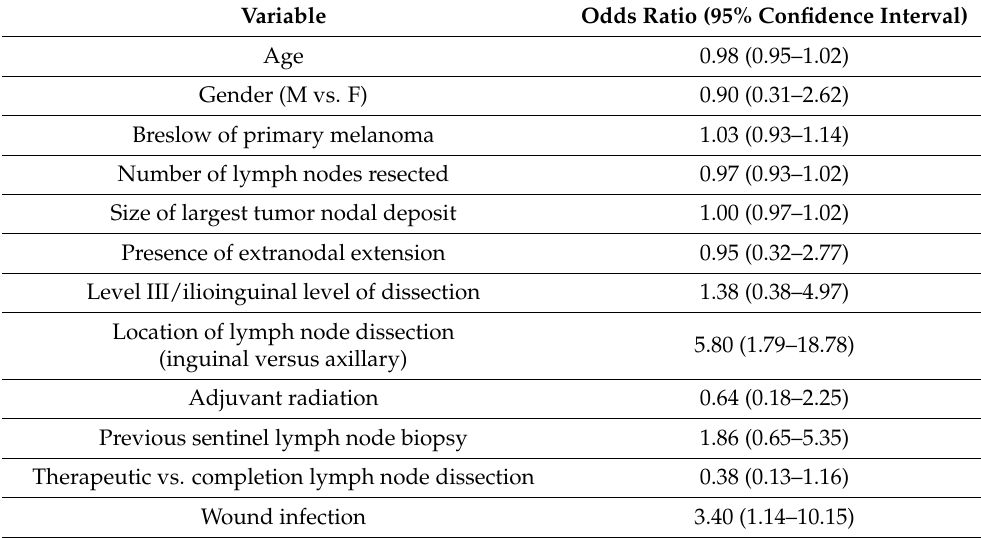
Table 3. Univariate analysis of the rate of lymphedema compared with predictive